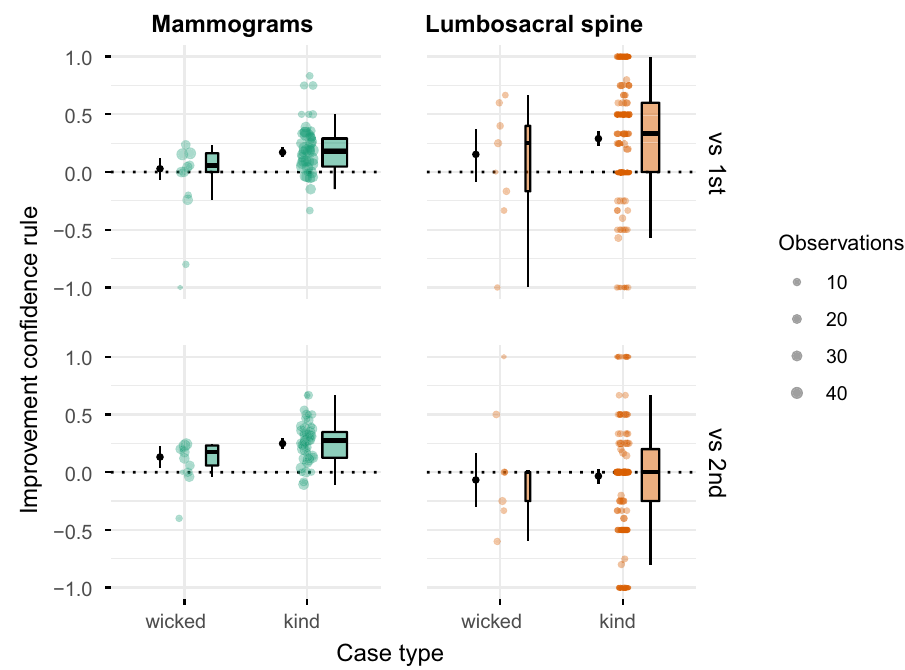
Figure 3. Empirical results comparing the accuracy of the confidence rule to the accuracy of first (upper panel) and second (lower panel) diagnoses for cases where experts were inconsistent, separately for wicked and kind cases and the two datasets (mammography and lumbosacral spine). Positive (negative) decimals on the y-axes show the extent to which the confidence rule increased (decreased) performance compared to the respective other strategy. Cases are shown as horizontally jittered dots; the size of a dot indicates the number of experts who provided different diagnoses for that case (see the legend labelled “Observations”). The distributions are summarized by boxplots (to the right of the dots); the boxplots consider the number of observations per case (weighted boxplots) and their width is proportional to the square root of the number of cases in the respective distribution. The point and line range to the left of the dots indicates the median and 95% credible interval of the posterior distribution of the expected average improvement (according to model M7; see Supplementary Table